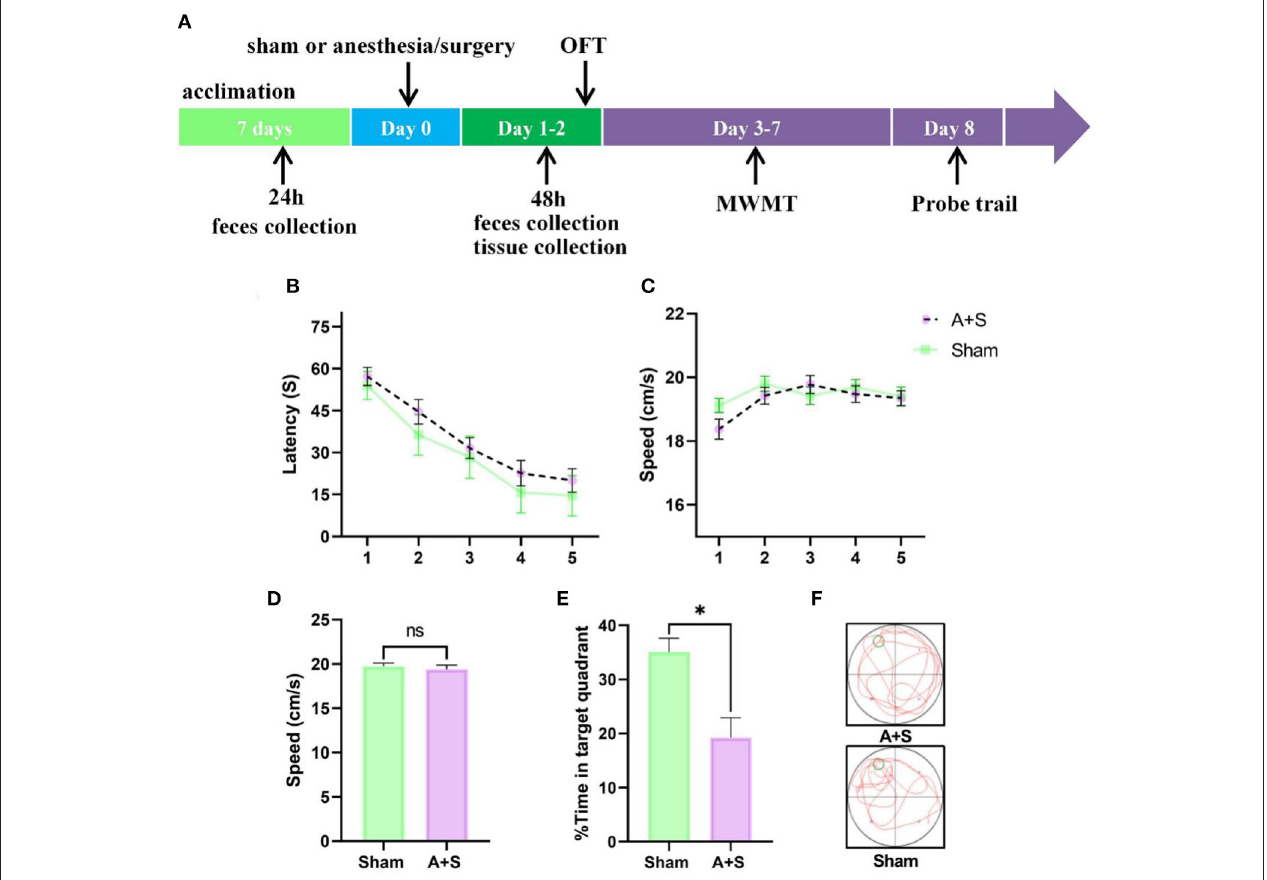
FIGURE 1 | Anesthesia/surgery influences neurobehaviors in aged mice. (A) Experimental timeline of the Morris water maze test. (B) Escape latency to reach the hidden platform during the 5 days of training (two-way ANOVA, p < 0.05). (C) Swimming speed during hidden platform training (two-way ANOVA, p > 0.05). (D) Difference in swimming speed between the two groups during the probe test (unpaired t -test, p > 0.05). (E,F) Time spent in the target quadrant during the probe test (unpaired t -test, * p < 0.05). A + S: anesthesia/surgery. * p < 0.05 ( n = 10 for both sham and A + S